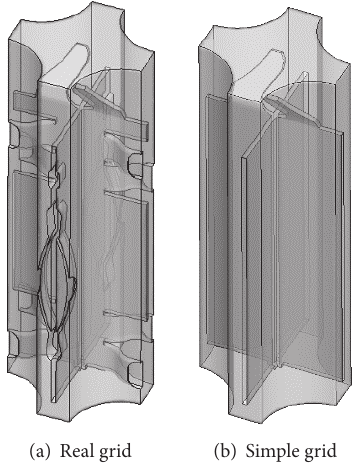
Figure 24: Simulation objects for structure research.